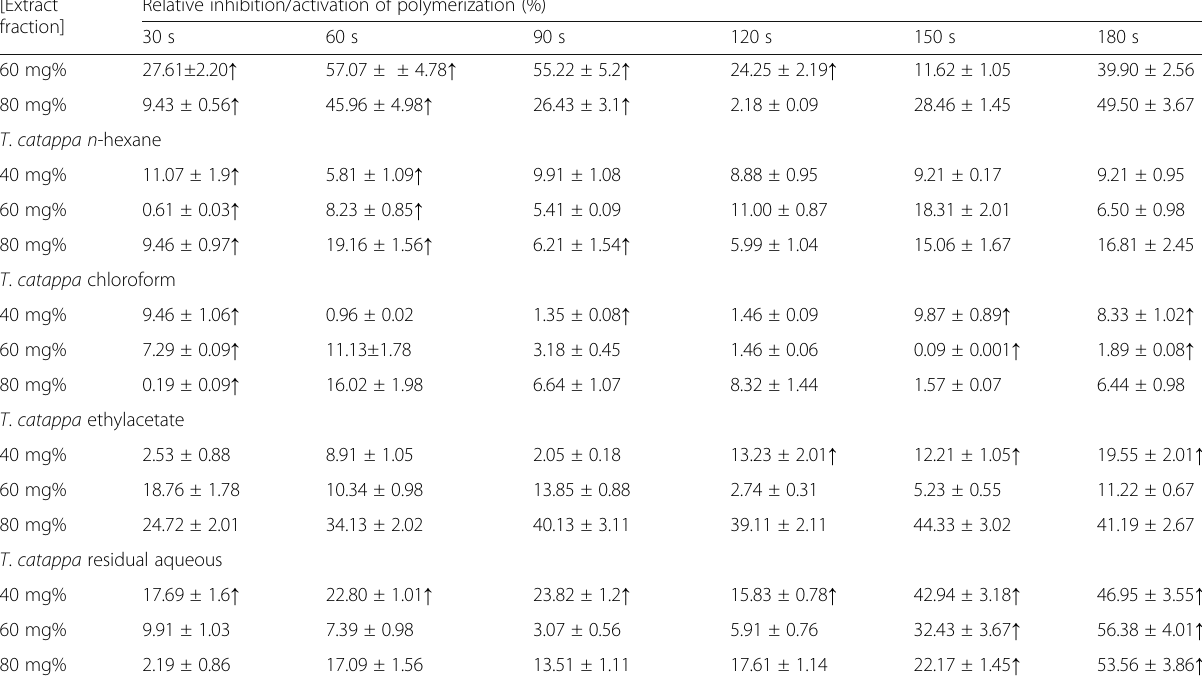
Table 2 Relative levels of inhibition/activation of poly-dHbS-M by fractionated leaf extracts of A. occidentale , P . guajava , and T . catappa (Continued) [Extract